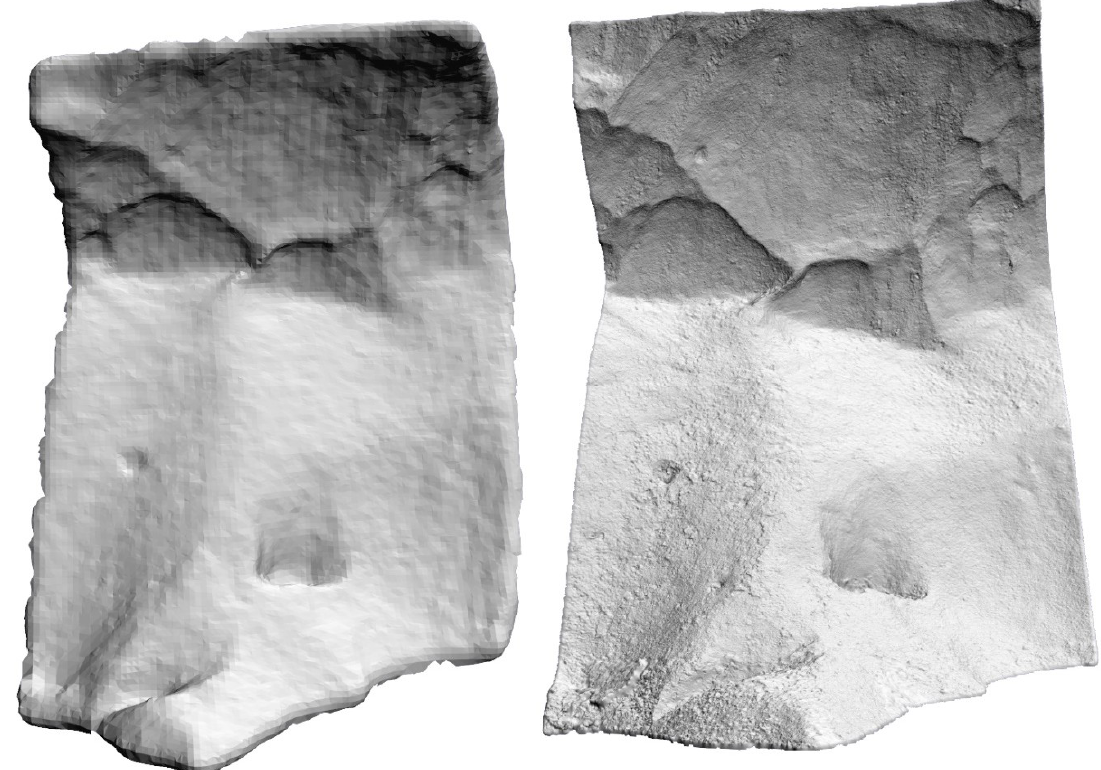
Figure 15. Mesh models created by Poisson Surface Reconstruction with Octree depth 12; left—laser scanning, right—photogrammetry.